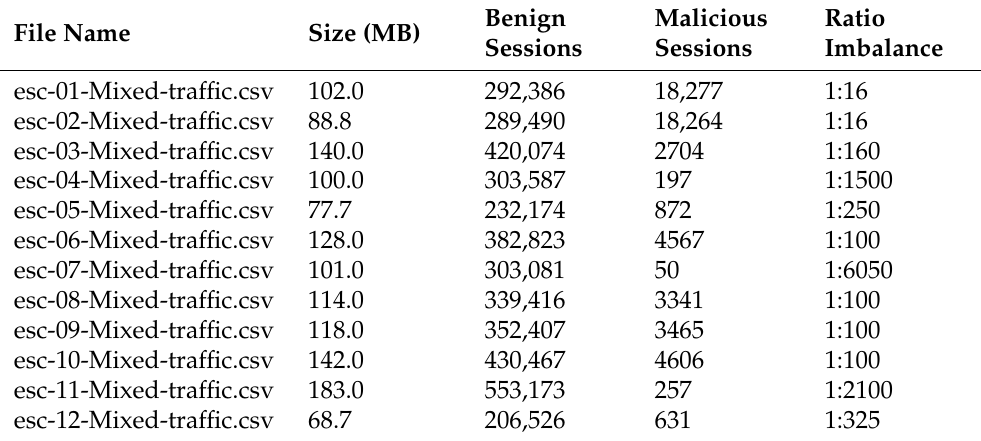
Table 5. Summary of the sessions on UAN-12